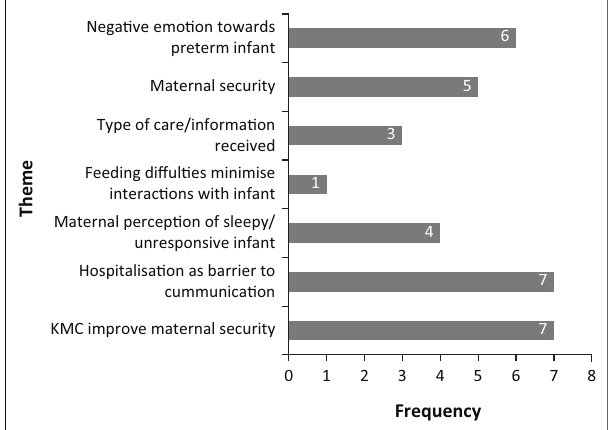
FIGURE 4: Bar graph representing the codes of relevant results from the data. KMC, Kangaroo mother